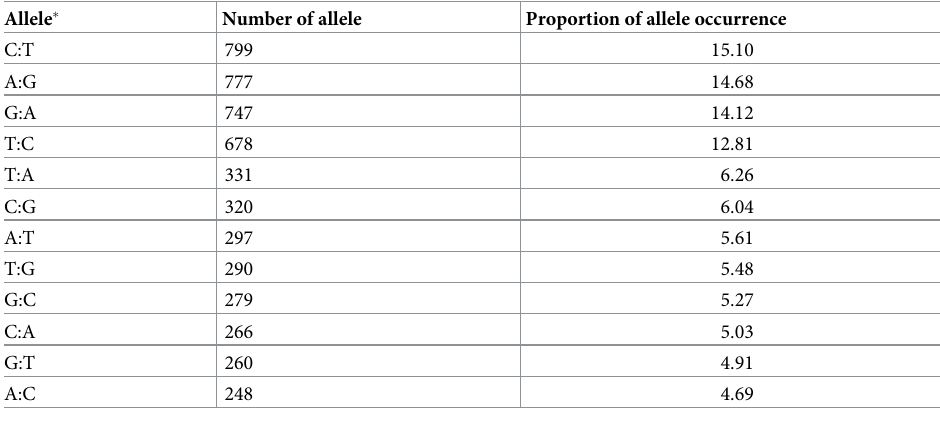
Table 2. SNP statistics in filtered data indicating number of allele and frequency of allele